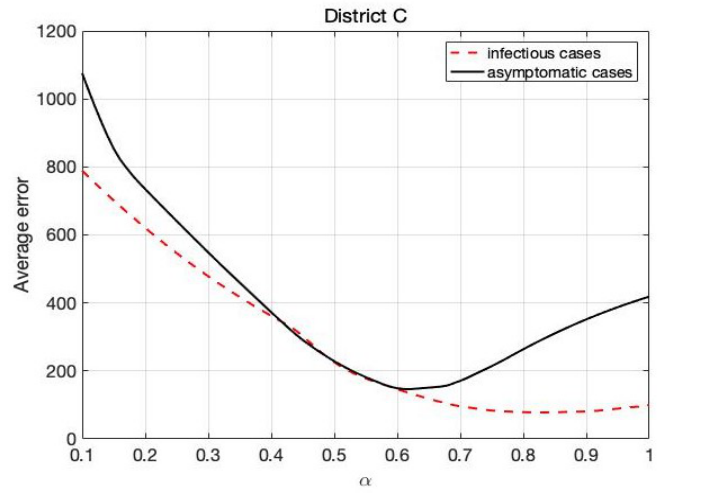
Figure 16. Model results for various